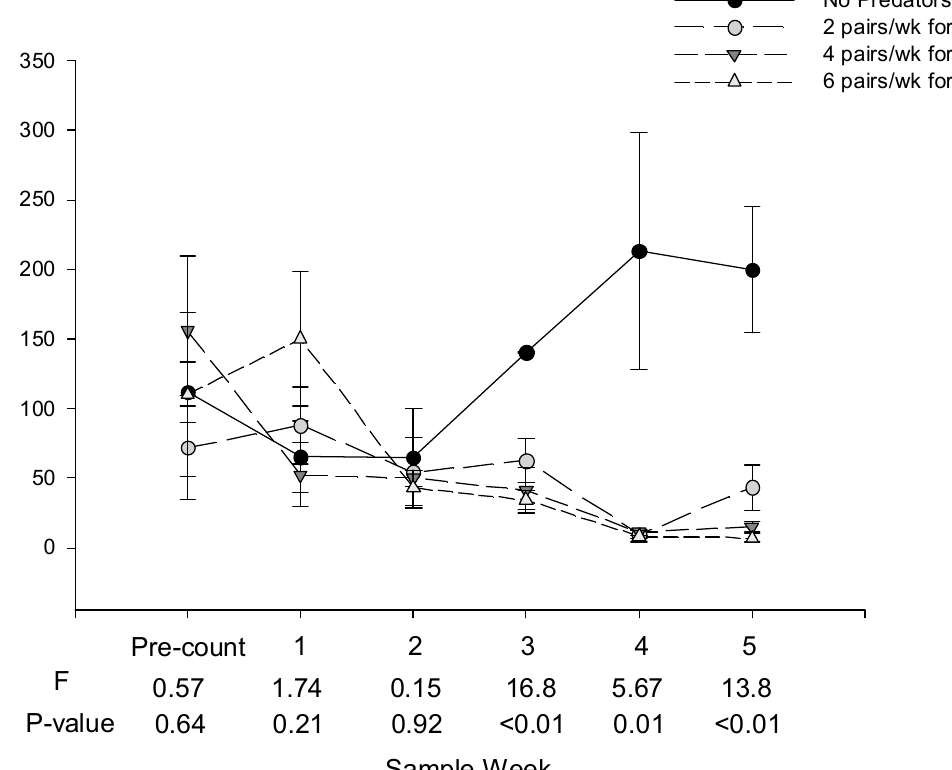
Figure 1. Mean ( ± SE) number of B. tabaci eggs per tomato leaf on tomato plants receiving low, medium and high release rates of D. hesperus . D. hesperus were released on 22 Nov, when the pre-count was taken, and 29 Nov and 6 Dec, 2016, the same days that readings 1 and 2 were collected; when sample dates coincide with release, cages were sampled first. Table 1. Mean ( ± SE) number of nymphal and adult D. hesperus 42 days after the initial release in cages containing four tomato and one mullein plant infested with B. tabaci .